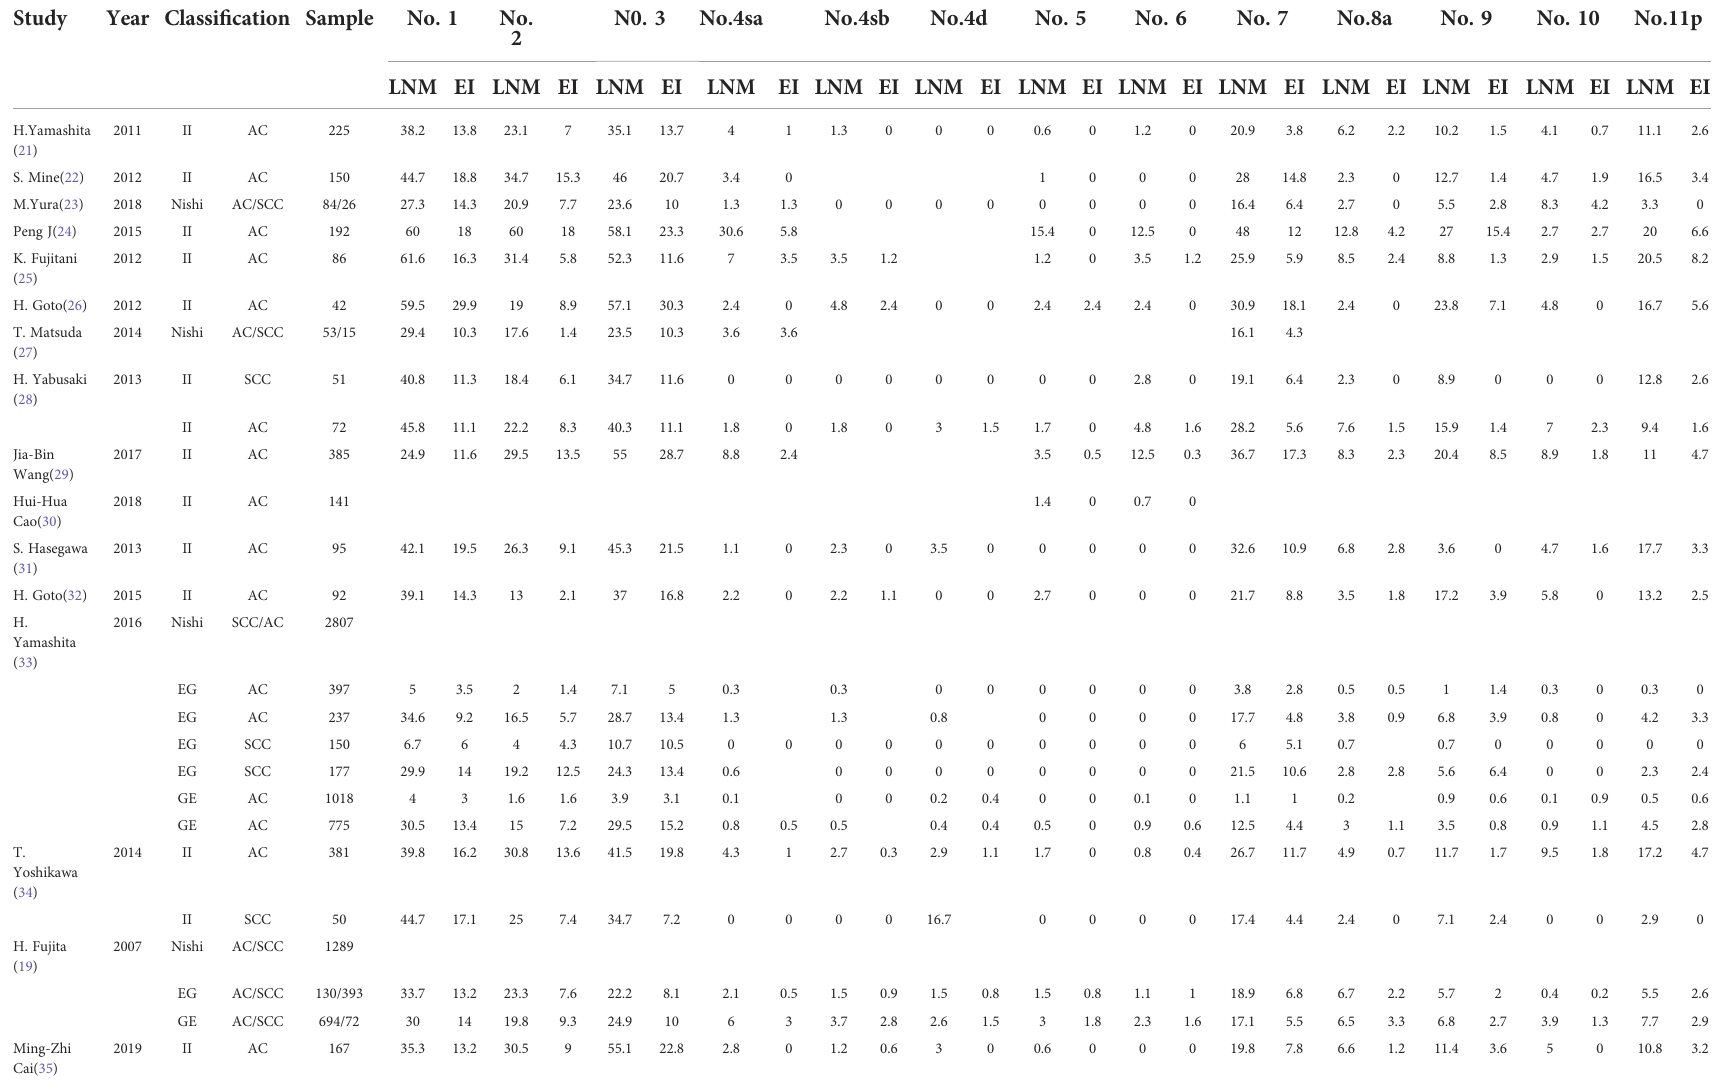
TABLE 3 Metastatic rate and therapeutic ef fi ciency index of each nodal station for esophagogastric junction carcinoma. Study